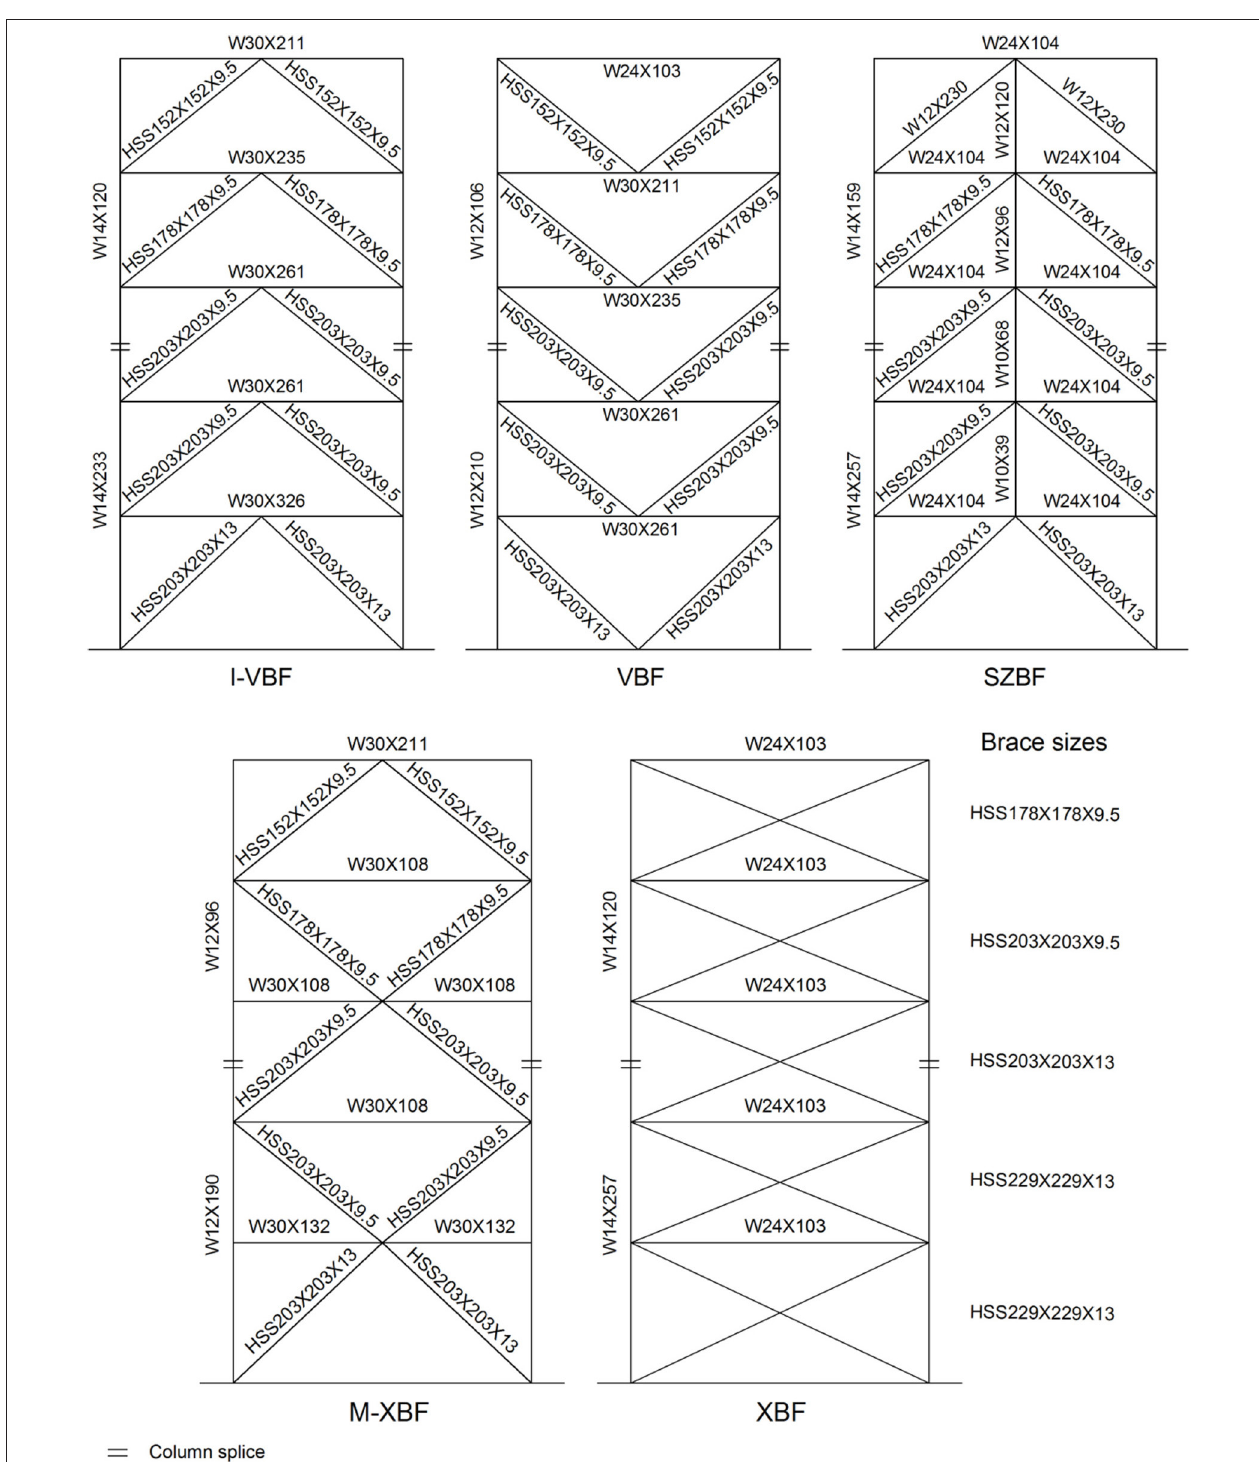
FIGURE 2 | Member sizes of the